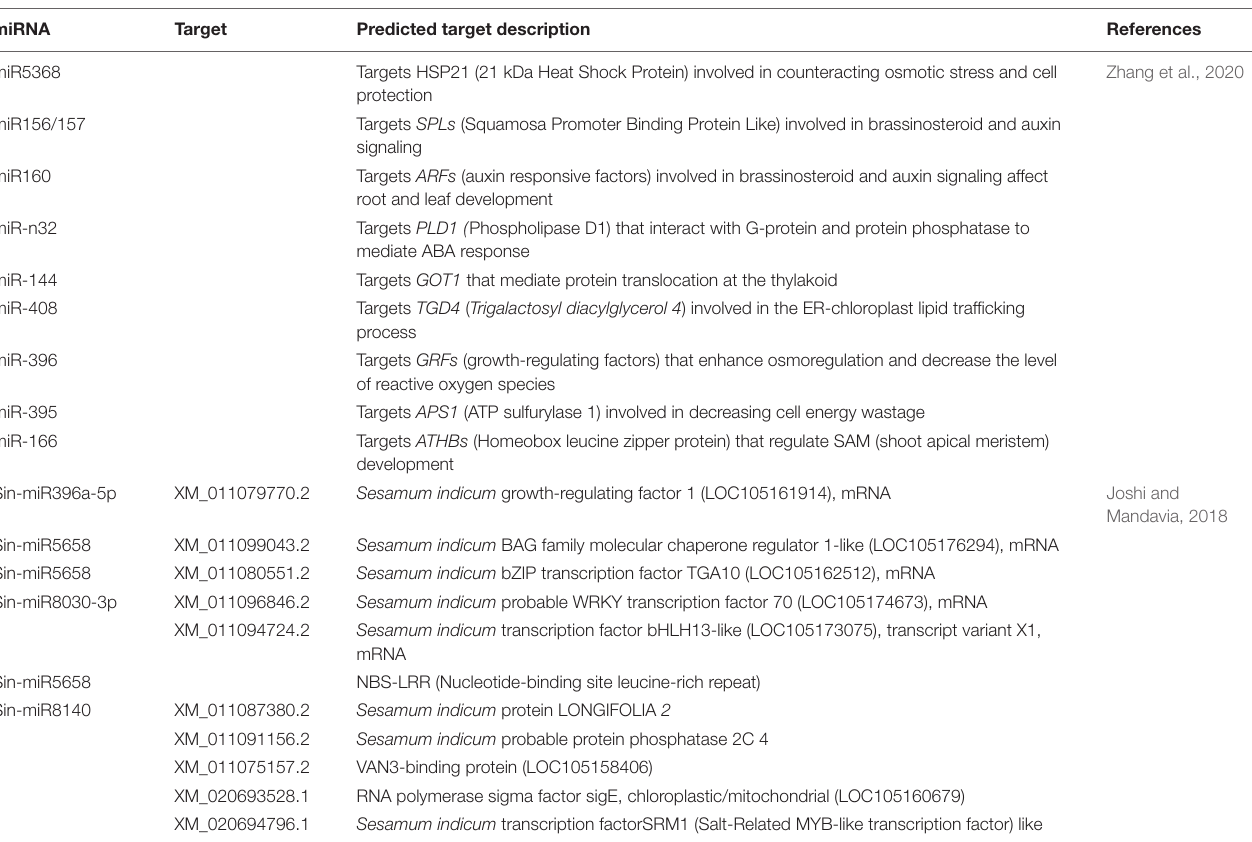
TABLE 9 | List of microRNA (miRNAs) observed in sesame and their predicted